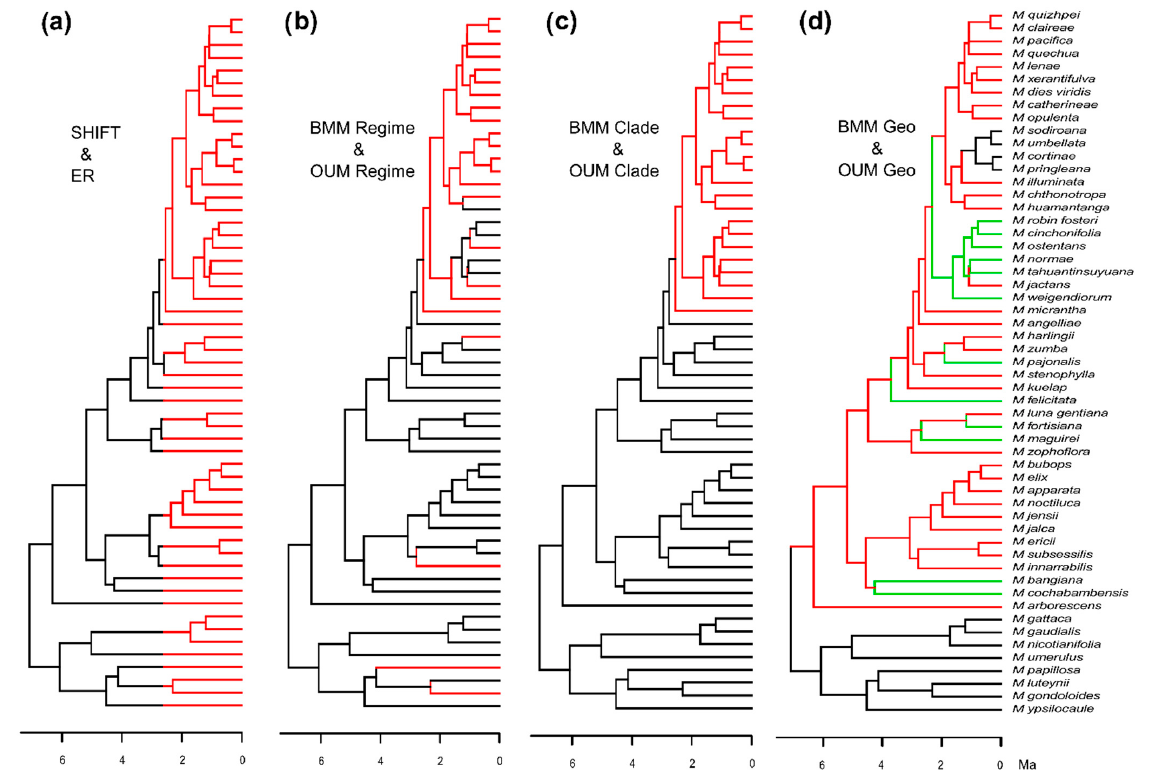
Figure 4. Mapping of time slices ( a ), regimes ( b ), taxonomy ( c ) and geography ( d ) on the MCC tree of the Andean species of Macrocarpaea that have morphological data (55 species) that were used to build the distinct models of trait evolution. ( a ) The mapping depicts part of the tree older than the Pleistocene climatic oscillations (PCO, >2.6 Ma) in black from those contemporaneous to the PCO in red. The SHIFT is a two rate Brownian model (BM) of trait evolution were black portions of the tree share the same rate of evolution σ 1 and red portions have a different rate σ 2 . The ER (for ecological release) is an Ornstein–Uhlenbeck model (OU) applied to the black part of the tree, followed by a BM applied to the red branches. ( b ) Black branches correspond to species occurring in the upper montane forest (UMF, >1800 m) and red branches to species occurring in the lower montane forest (LMF, <1800 m). States for internal branches were estimated by using maximum likelihood methods (ML, see Methods for details). The BMM Regime is a two-rate regime specific BM model, were black branches have a rate σ 1 and red branches have another rate σ 2 . The OUM Regime is a two optimum regime specific OU model, where black branches have an optimum θ 1 and red branches have another optimum θ 2 . ( c ). Red branches correspond to the clade of the M. micrantha clade and black branches correspond to parts of the tree outside the M. micrantha clade. The BMM Clade is a two-rate clade-specific BM model (black = σ 1 , red = σ 2 ) and the OUM Clade is a two-optima clade-specific OU model (black = θ 1 , red = θ 2 ). ( d ) Black, red and green branches correspond to species occurring in the Northern Andes, the Amotape-Huancabamba zone and the Central Andes, respectively. States for internal branches were inferred by using ML methods. The BMM Geo is a three rates region specific BM model (black = σ 1 , red = σ 2 , green = σ 3 ) and the OUM Geo is a three optima region specific OU model (black= θ 1 , red = θ 2 , green = θ 3